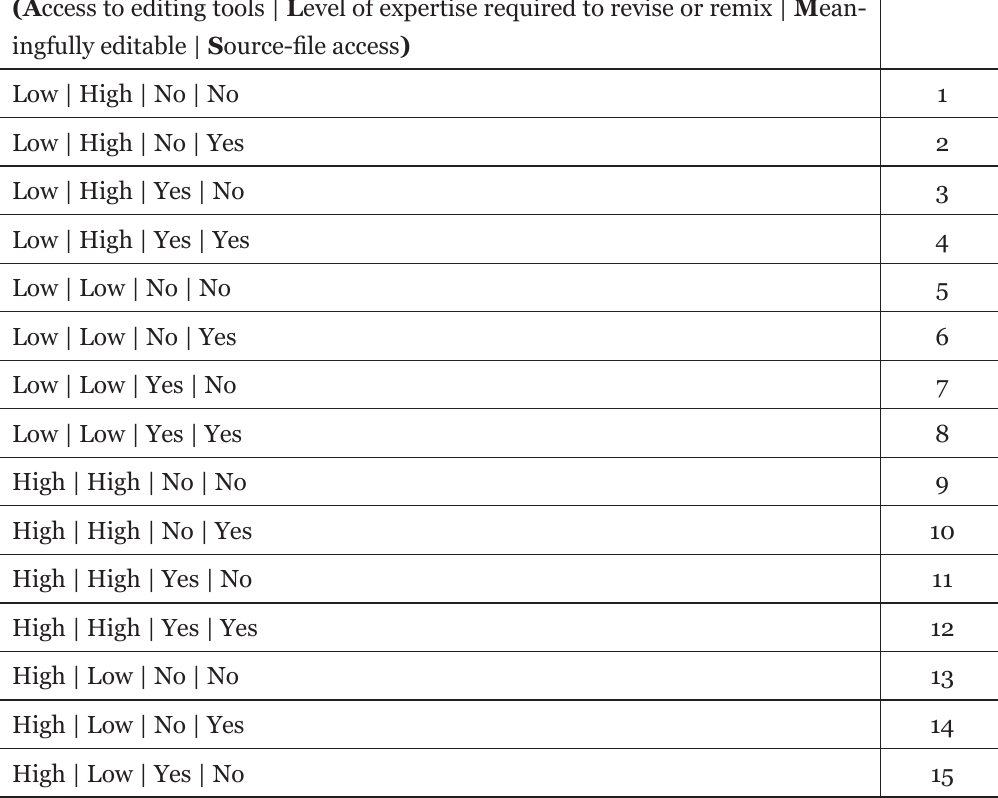
The Level of Access Based on the ALMS Analysis